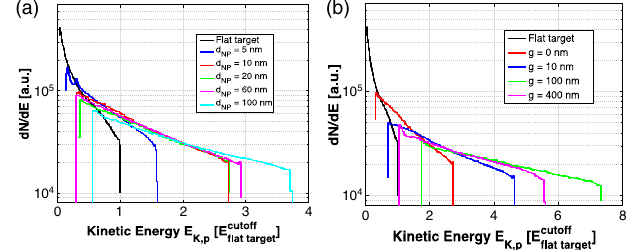
FIG. 4. (a) Proton kinetic energy spectra for different NP — the gap size g between the different nanoparticles diameters d NP is kept at g ¼ 0 nm. (b) Influence of the gap size g on the proton spectra — the nanoparticle dimension has been kept fixed at ¼ 10 nm. Since the number of protons in the simulation is d NP fixed and the plane-wave approximation is used, the minimum energy (left cutoff in the spectrum) is shifted with an increasing maximumprotonenergy.Theflattargetcutoffnormalizationenergy is 4.5